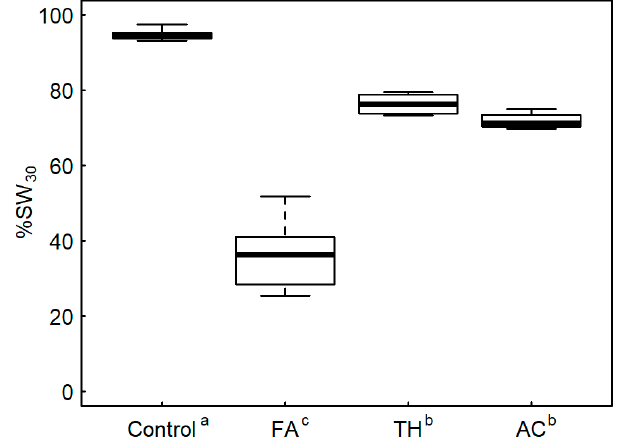
Figure 4. Percentage of total swelling that has occurred after 30 min (%SW 30 ). Superscripted letters on the x -axis indicate significant differences according to Tukey’s HSD test (95% confidence level).